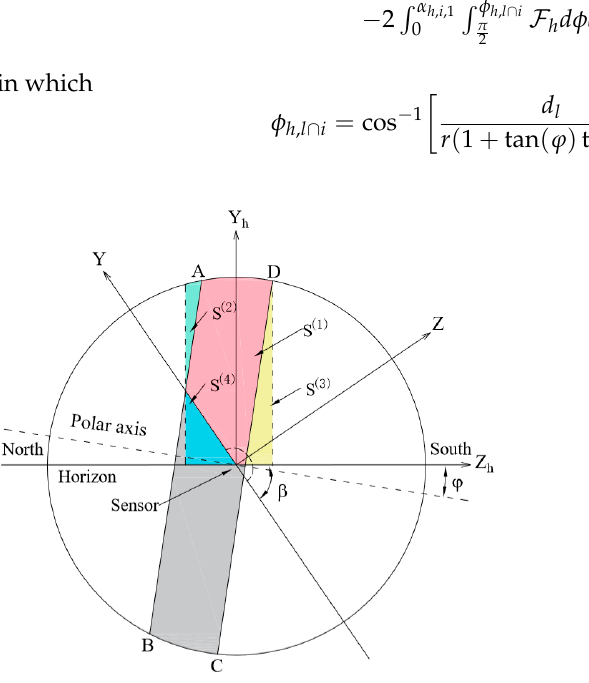
Figure 8. Schematic diagram for the calculation of 𝑆 (cid:3035) while 𝑑 (cid:3039) < 0 < 𝑑 (cid:3045) and 𝜙 (cid:3035),(cid:3039),(cid:3040)(cid:3028)(cid:3051) ≥ 𝜙 (cid:3035),(cid:3039)∩(cid:3036) ≥